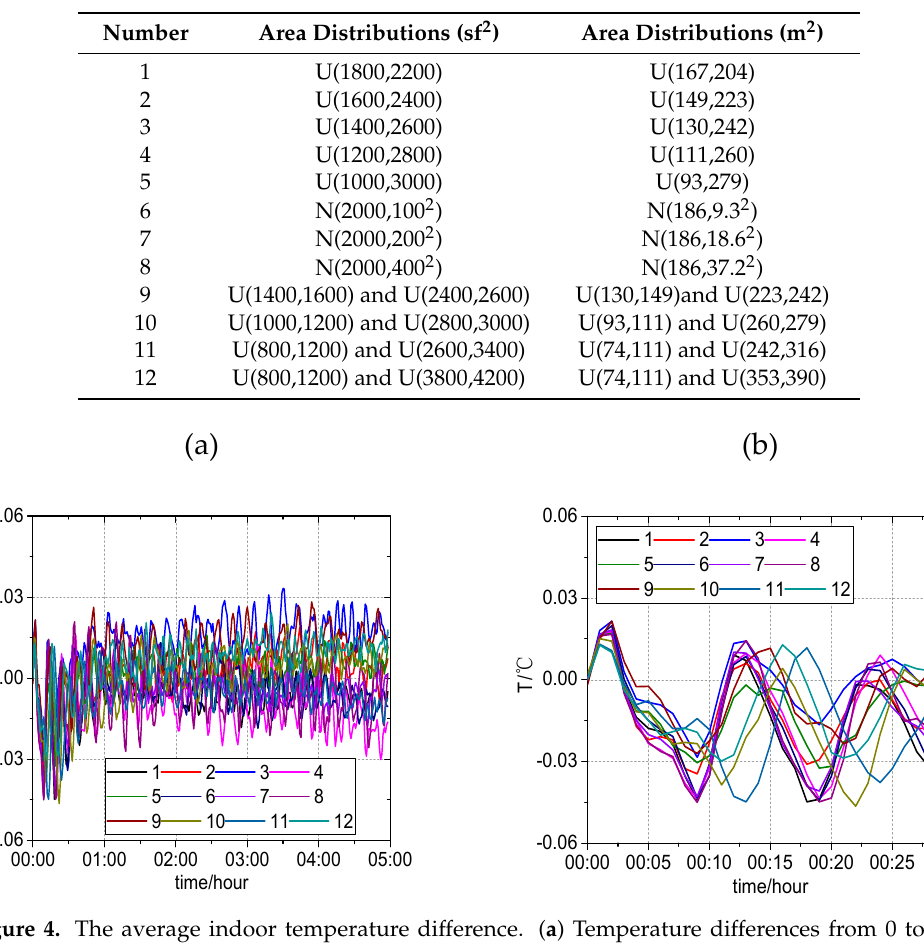
Figure 5. The aggregated responses of 2000 homogeneous and heterogeneous TCLs.